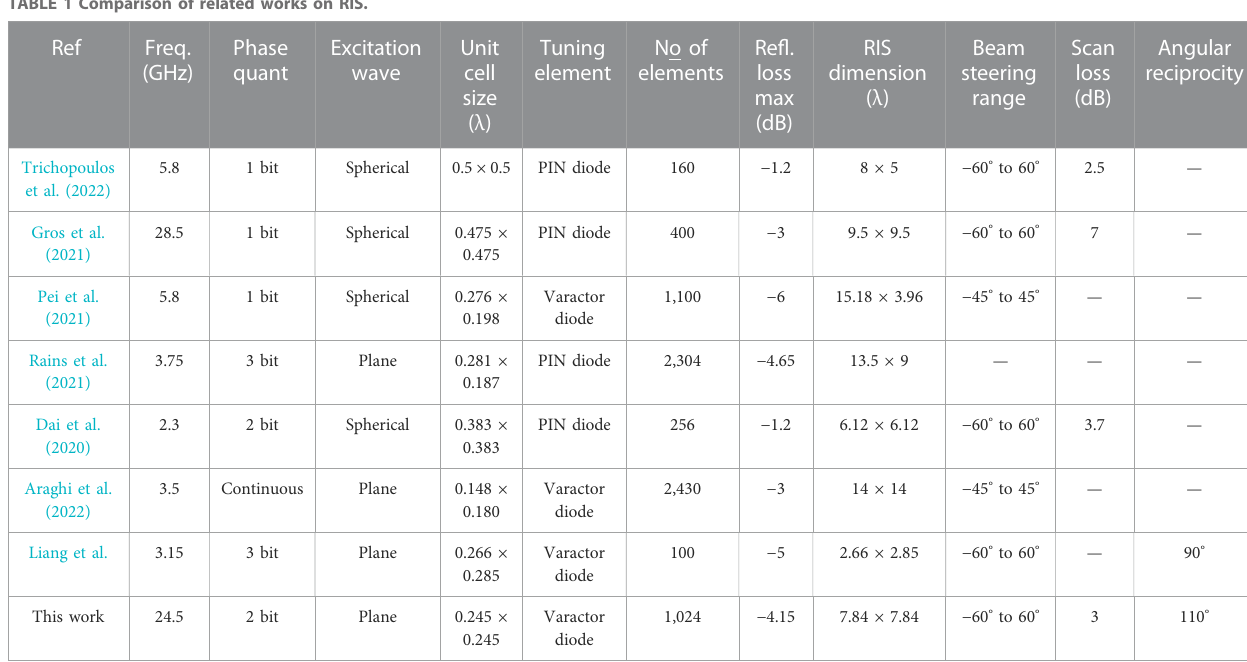
TABLE 1 Comparison of related works on